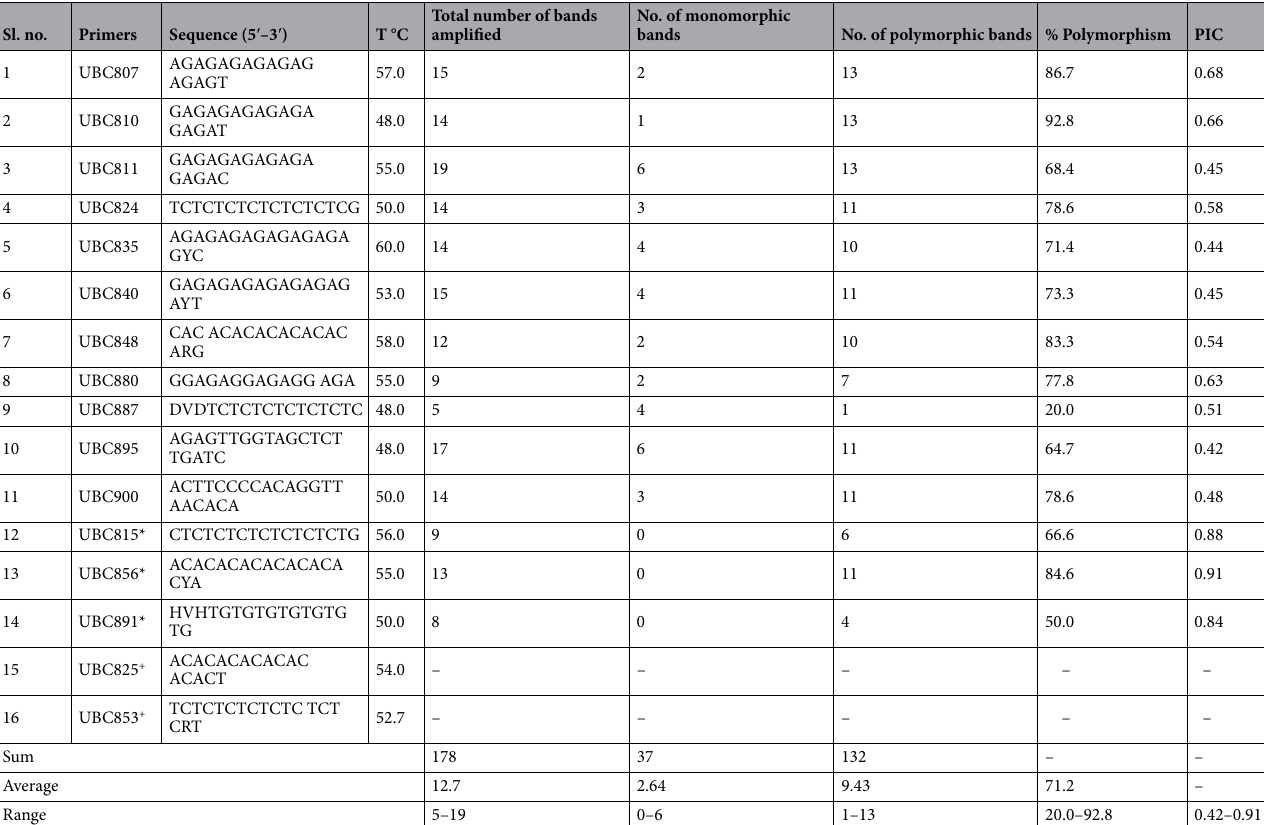
Table 5. Genetic diversity analysis of three dragon fruit ( Hylocereus ) species grown under Andaman and Nicobar Island conditions using ISSR markers. R = (A or G), Y = (C or T), D = (A, G or T), H = (A, C, T), V = (A, C or G). UBC, ISSR primers, designed from University of British Columbia, Vancouver, Canada.